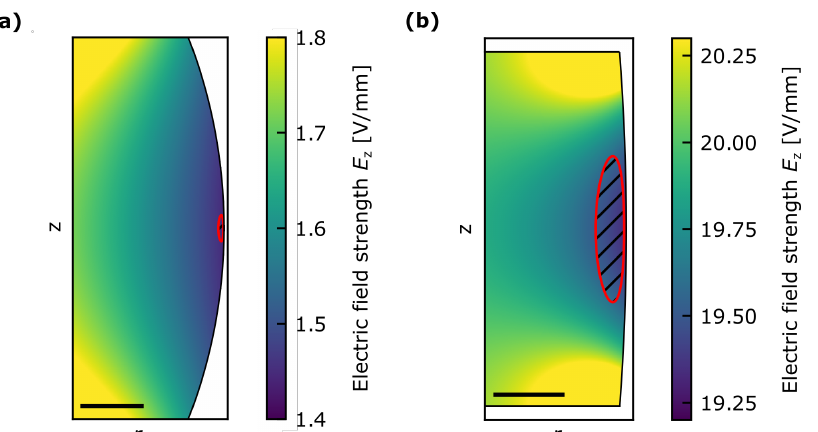
Figure 3. Two examples of electric field distributions E z for different thicknesses. The distribution is plotted based on (cid:101) C . The red area indicates where the intensity of the fundamental optical mode is larger than 10% of its maximum. The black bar has in ( a ) a size of 50 µm and in ( b ) of 10 µm. For better visibility the range of field values is limited such that the region of interest provides enough